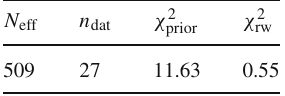
Inthefollowing,wepresentresultsseparatelyforinclusive Table 8 Same as Table 6, now